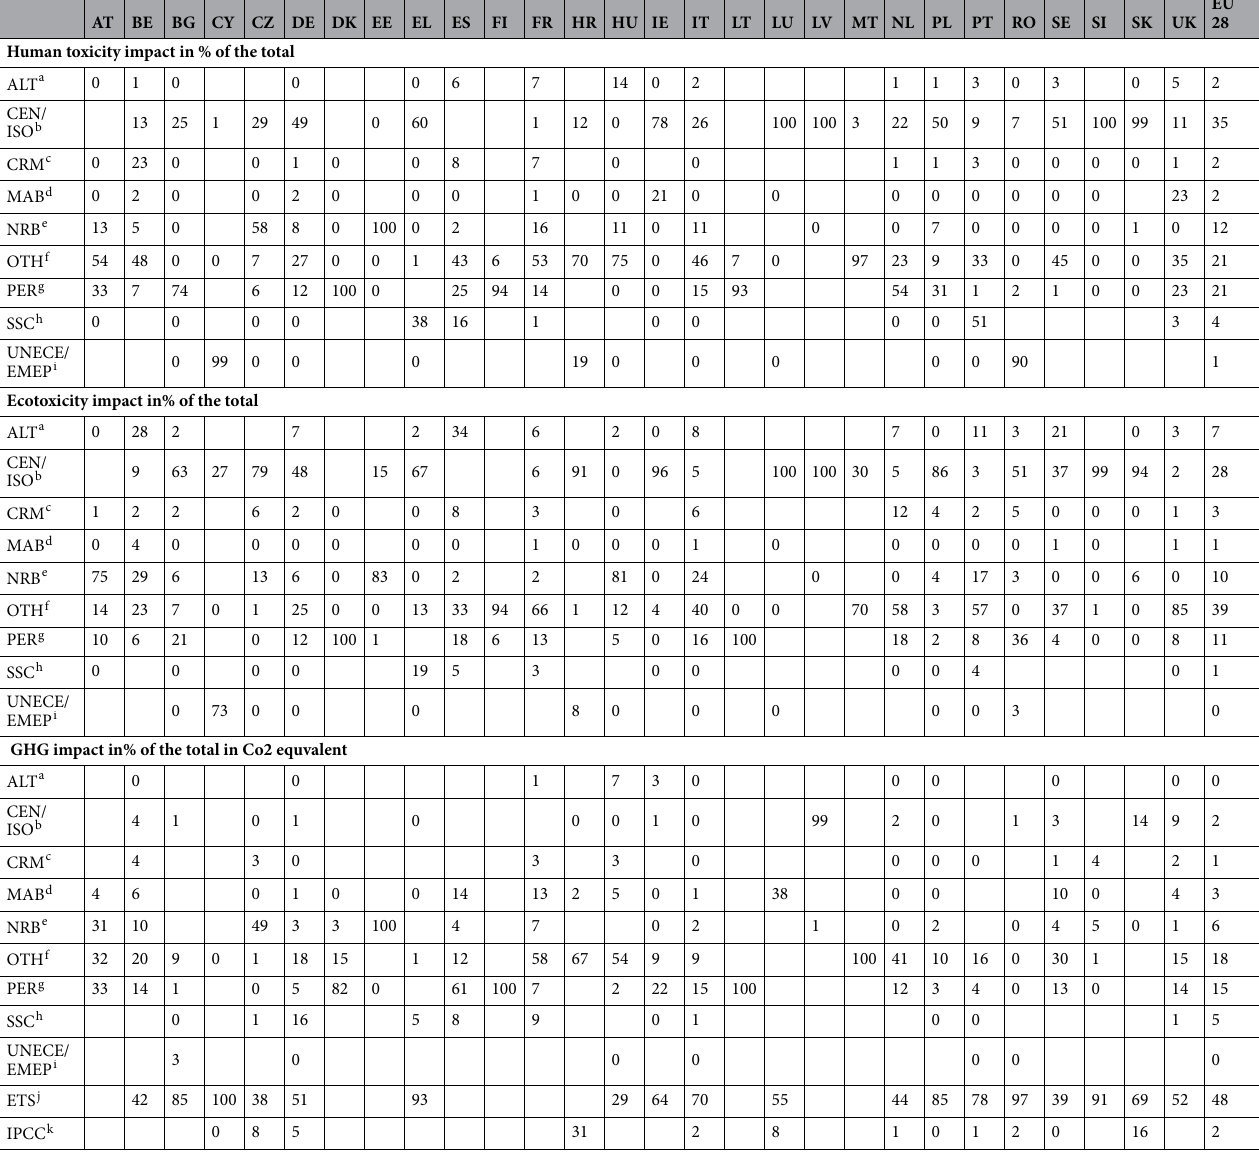
Table 7. Shares of pollutant released by measurement/calculation standard types in% of the total (in 2017). a ALT Alternative measurement methodology in accordance with existing CEN/ISO standards. b CEN/ ISO Internationally approved measurement standard. c CRM (Certified Reference Materials) Measurement methodology for the performance of which is demonstrated by means of certified reference materials and accepted by competent authority. d MAB Mass balance method which is accepted by the competent authority. e NRB National or regional binding measurement/calculation methodology prescribed by legal act for the pollutant and facility concerned. f OTH Other measurement/calculation methodology. g PER Measurement/ Calculation Methodology already prescribed by the competent authority in a licence or an operating permit for that facility. h SSC European-wide Sector Specific Calculation method. i UNECE/EMEP UNECE/EMEP EMEP/ CORINAIR Emission Inventory Guidebook. j ETS Emission Trading Scheme Guidelines for the monitoring and reporting of greenhouse gas emissions. k IPCC Intergovernmental Panel on Climate Change Reference